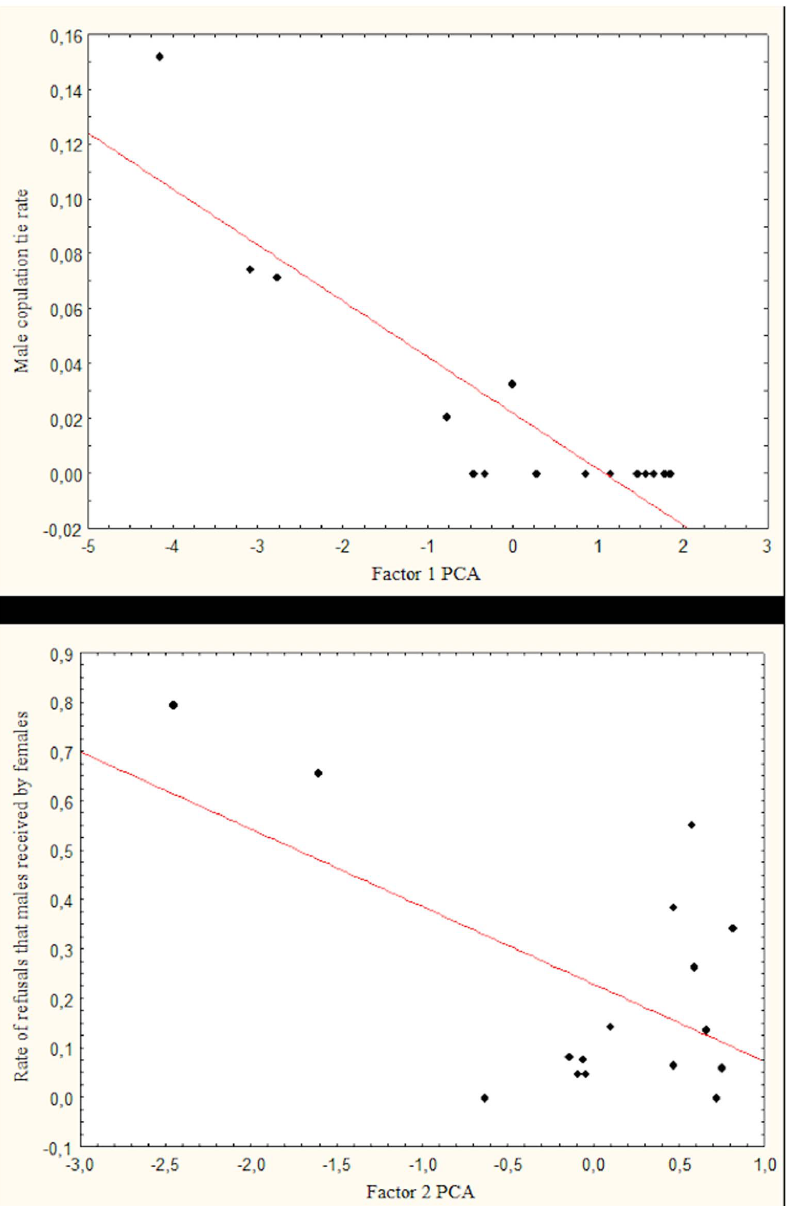
Figure 2. Results of the general linear models developed for males. (a) The relation between ‘male copulation tie rate’ and the first factor of the PCA. High negative values on factor 1 indicate high-ranking males who often led the pack, who were frequently approached within 1 metre by females and who displayed both a high rate of affiliative behaviour and a low rate of aggressive behaviour towards females; (b) The relation between ‘‘rate of refusals that males received by females’’ and the second factor of the PCA. High negative values on factor 2 indicate a high rate of aggressive behaviour displayed by males towards females.